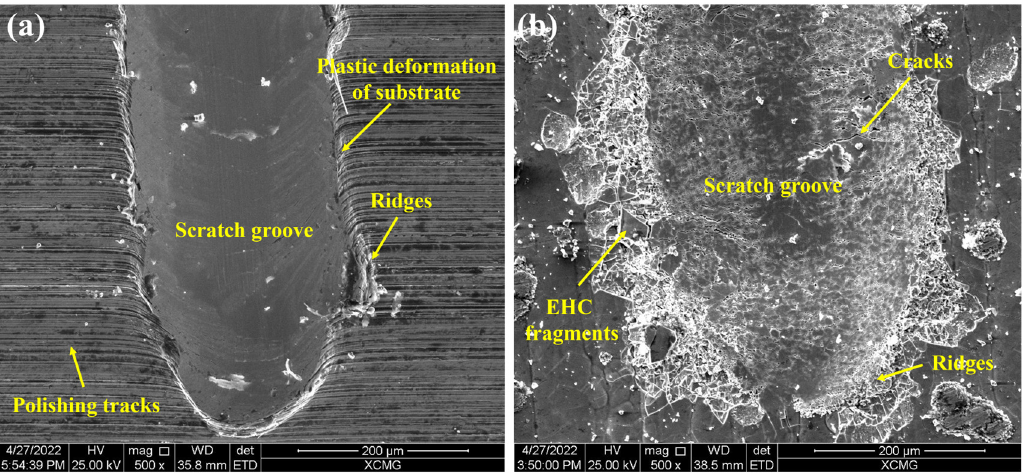
Figure 13. Micro-morphology of scratch grooves. ( a ) EHLA JG-11; ( b ) EHC.